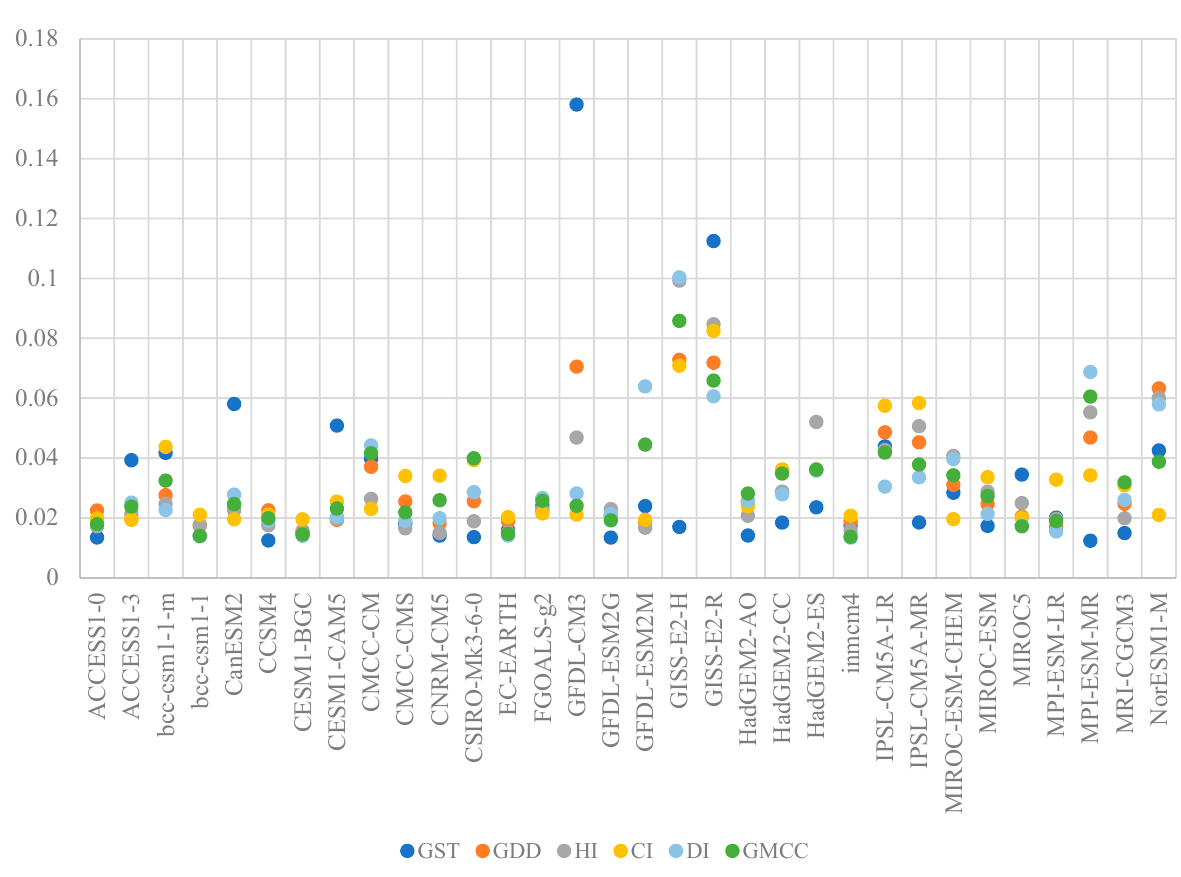
Figure 4. Normalized independence weights developed for the growing season average temperature (GST), growing degree days (GDD), Huglin index (HI), cool night index (CI), dryness index (DI), and the Géoviticulture multicriteria climate classification (GMCC) viticulture climate classification indices throughout the Willamette Valley American Viticultural Area using the Localized Constructed Analogs (LOCA) Coupled Model Intercomparison Project phase 5 (CMIP5) model archive [40,41] for its defined historic period (1950–2005). Table 4. For the Willamette Valley American Viticultural Area (AVA) and growing season average temperature (GST), growing degree days (GDD), Huglin index (HI), cool night index (CI), dryness index (DI), and the Géoviticulture mul- ticriteria climate classification (GMCC) viticulture climate classification indices, computed root mean squared error (RMSE) values obtained by comparing climate index specific processed daily Localized Constructed Analogs (LOCA) Coupled Model Intercomparison Project phase 5 (CMIP5) model historic datasets [40,41] with their equivalently processed observed data counterparts [24,41] using the skill weighting, and skill and model interdependence weighting methods [17,23]. N denotes the number of LOCA CMIP5 models defining the ensemble.